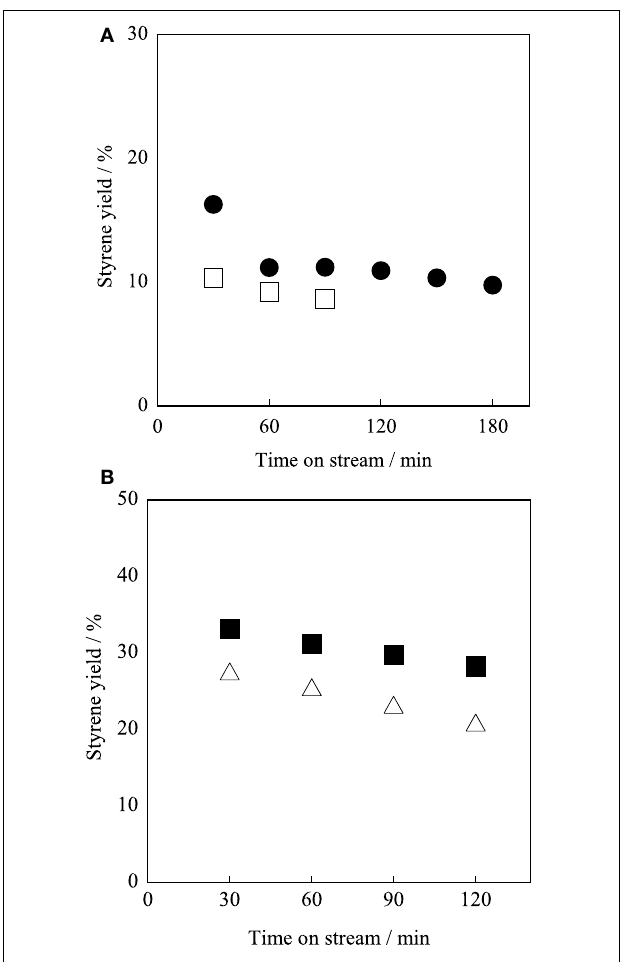
FIGURE 6 | Catalytic activity tests over (filled symbols) Ba 0 . 4 Sr 0 . 6 Fe 0 . 6 Mn 0 . 4 O 3 − δ and (open symbols) Fe–K catalysts (A) at 783K and under steam/EB molar ratio of 12, (B) at 813K under steam/EB molar ratio of 2.